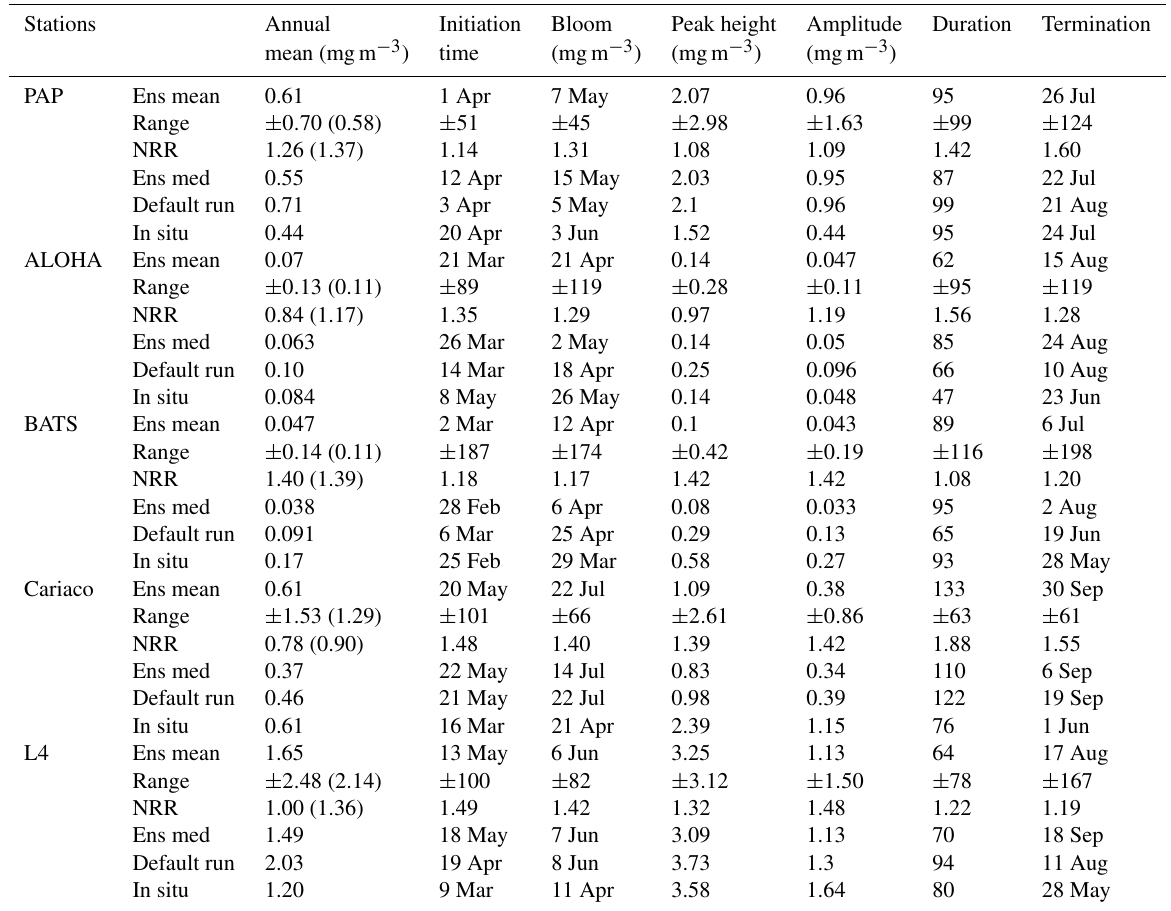
Table 4. Surface annual mean and phytoplankton phenology from the in situ, ensemble mean, median, and default run. The ranges and NRR in the brackets are the values for changing the functional form one process at a time (shown in Fig.